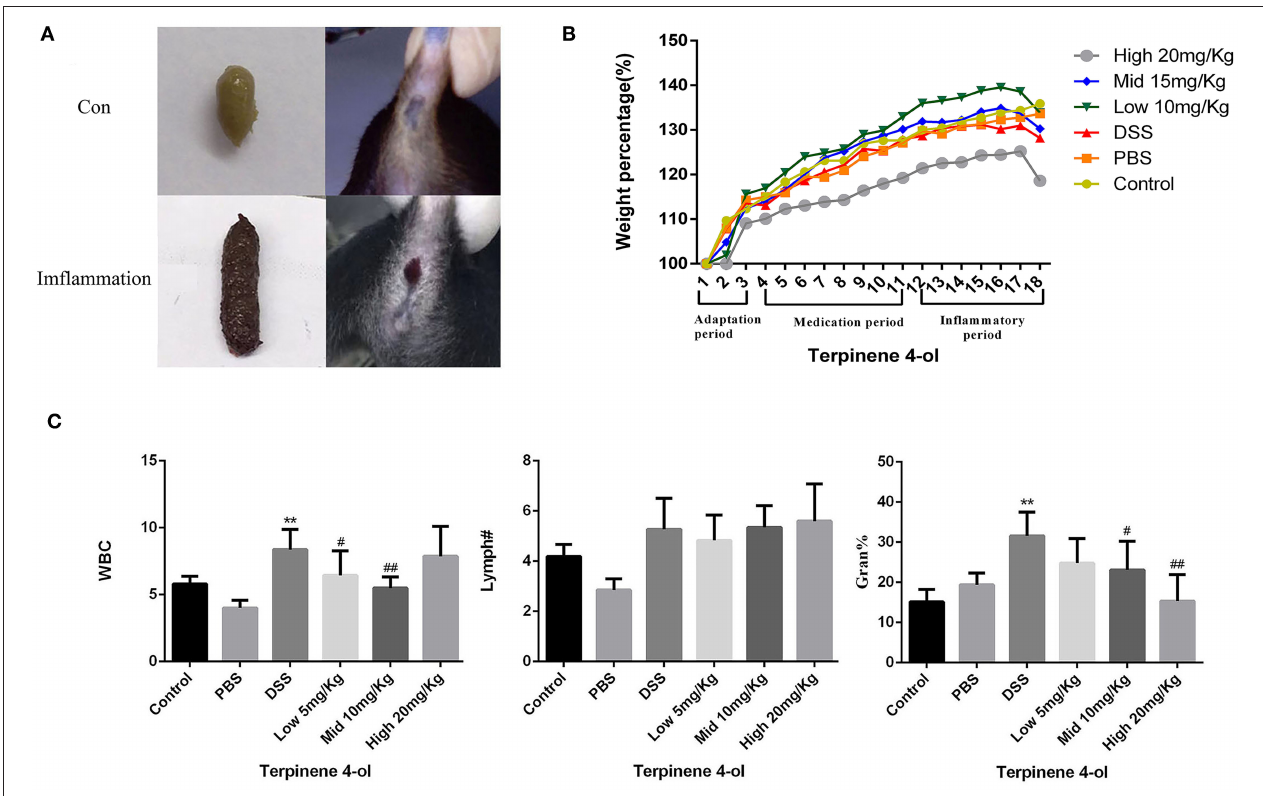
FIGURE 7 | Effect of TER on colonic inflammation in mice with DSS-induced colitis. Colonic inflammatory responses after drinking DSS solution. (A) Severe bloody stools, (B) relative BW changes, (C) and the percentages of white blood cells, lymphocytes, and neutrophils in mice treated with TER. ** and ## display similar means with above